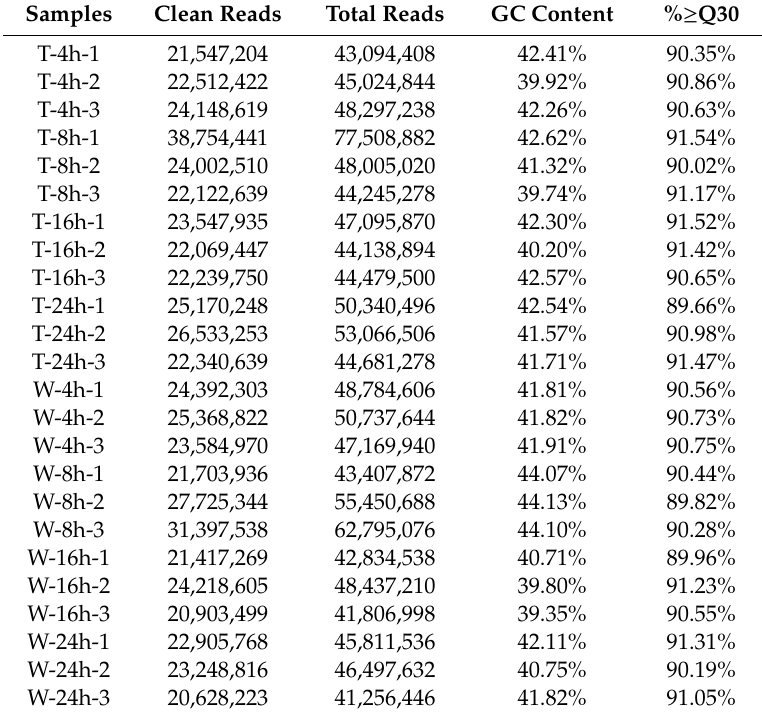
Table 1. Statistical summary for M. anisopliae -infected and control groups.